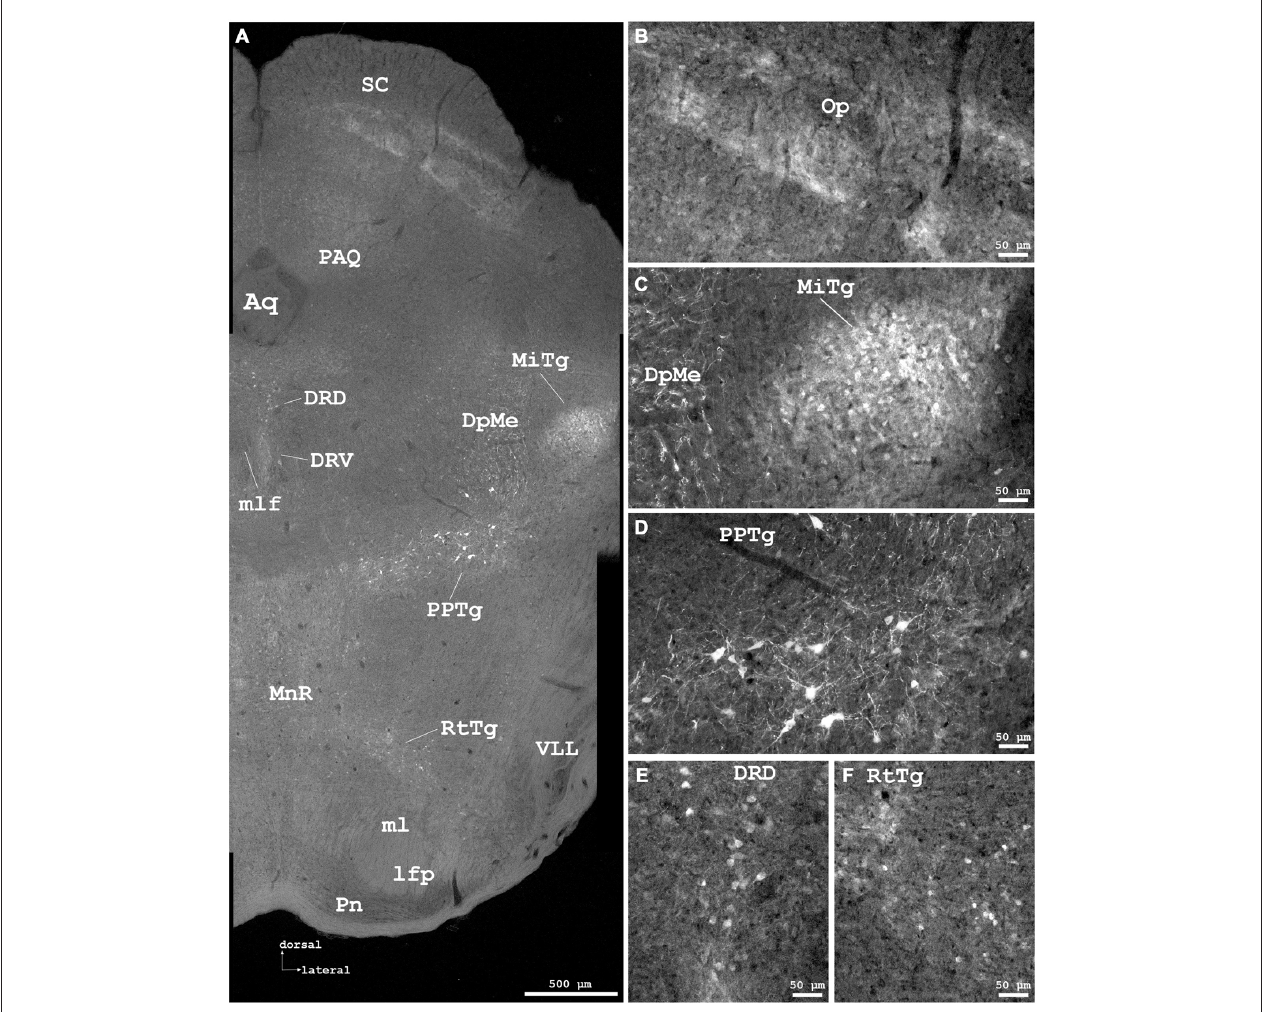
FIGURE 6 | Cygb-immunofluorescence in a frontal section of the mouse brain at the level of approximately interaural − 0.4 mm, corresponding to Figure 66 of the mouse brain atlas. (A) Low power photomicrograph (MIA) showing superior colliculus (SC), dorsal raphe and tegmental nuclei. (B–F) Higher magnifications from (A) demonstrating Cygb-IR neuronal structures. (B) Faintly labeled fiber systems and neuronal somata in the optic nerve layer of the SC (Op). (C) Small neurons with only few processes are found in the microcellular tegmental nucleus (MiTg), fiber systems in the deep mesencephalic nucleus (DpMe). (D) Large neurons with multiple processes are present in the pedunculopontine tegmental nucleus (PPTg). (E) IR neurons in the dorsal and ventral aspects of the dorsal raphe (DRD, DRV), and (F) in the reticulotegmental nucleus of the pons (RtTg). Abbreviations: Aq, aquaeductus cerebri; lfp, longitudinal fascicle of the pons; ml, medial lemniscus; mlf, medial longitudinal lemniscus; MnR, median raphe nucleus; PAQ, periaqueductal gray; Pn, pontine nuclei; VLL, ventral nucleus of the lateral lemniscus.